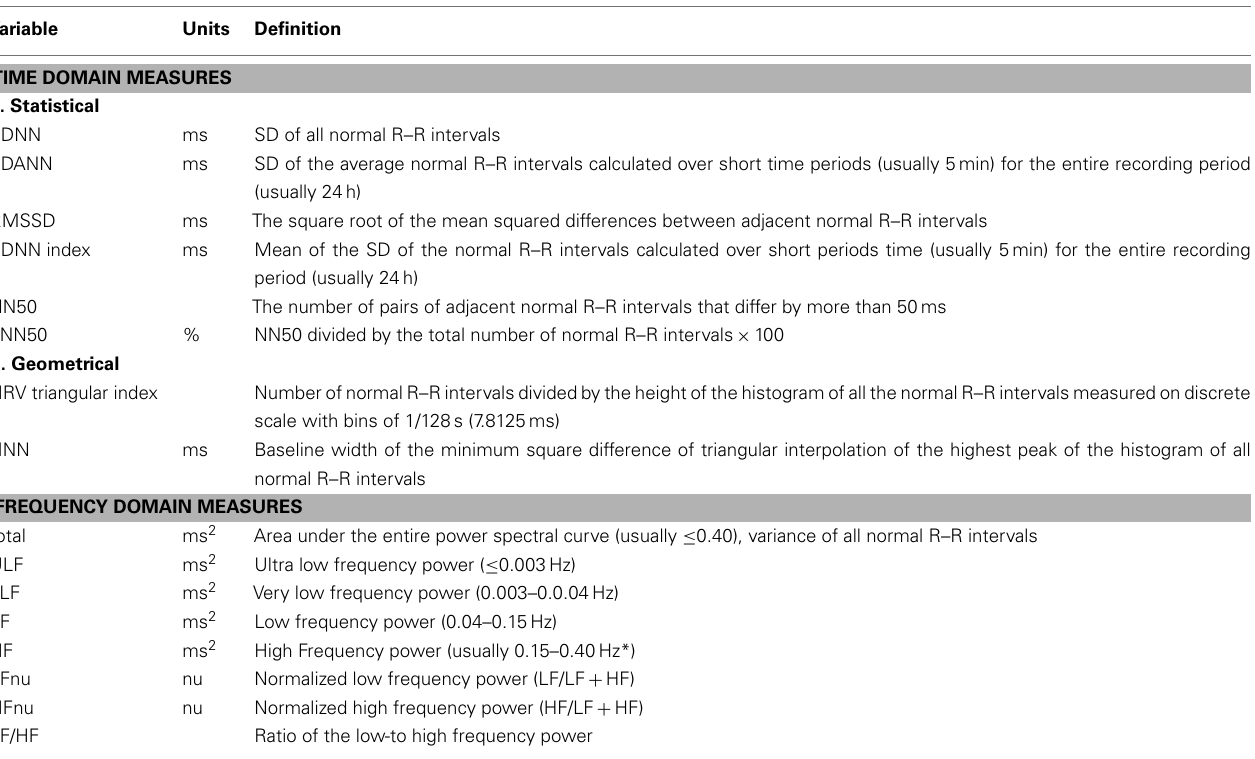
Table 1 | Conventional heart rate variability